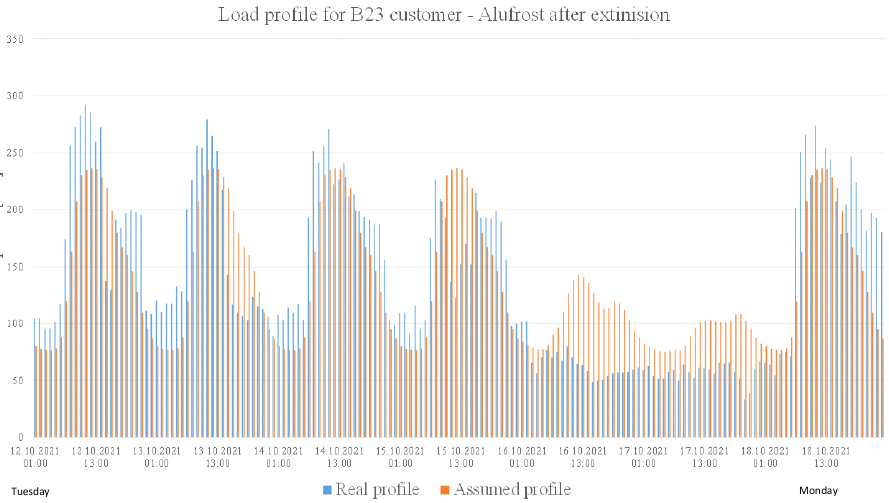
Figure 5. Comparison between the assumed B23 profile for the metallurgy company after the multiplication of 1.4 and real measurement.